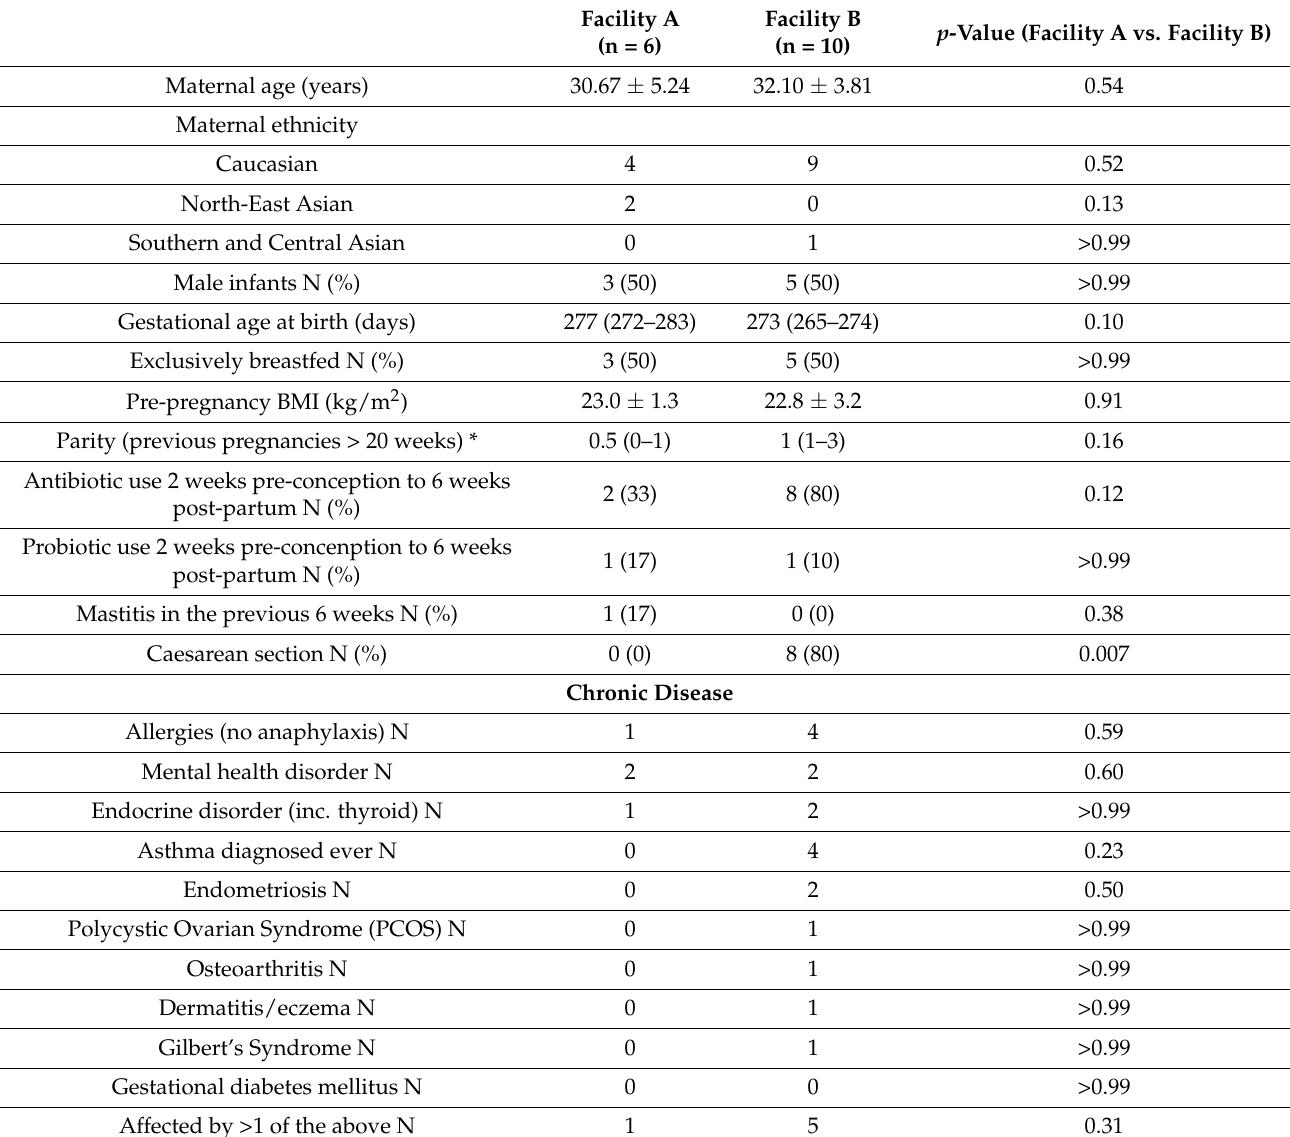
Table 1. Participant characteristics of samples sent to Facility A and B for metagenomic shotgun sequencing. * Incomplete parity data: n = 4 Facility A, n = 7 Facility